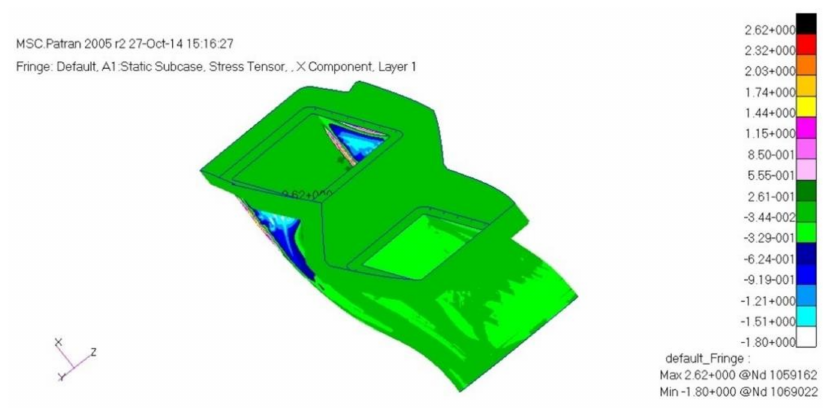
Figure 9. Stress analysis result: layer 1.